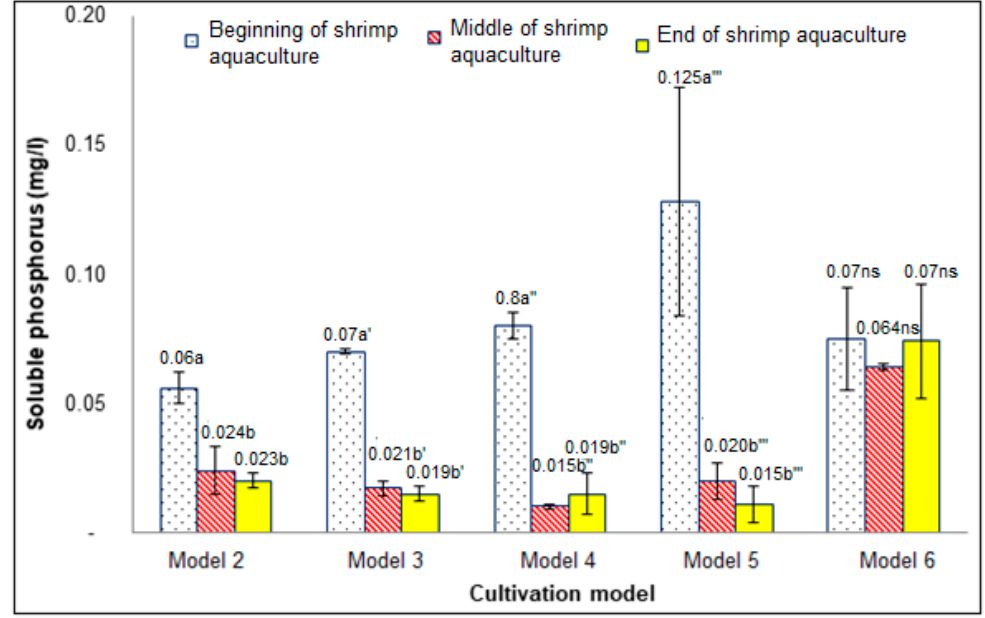
Figure 5. Variations of soluble phosphorus content in farming models. Notes: a and b are compared according to sampling time, the same letters within the same column or row have no significant difference. The symbols ’, ’’, ’’’ are used to distinguish different experimental or model areas. ns: no difference (compared at a significance level of 5%).